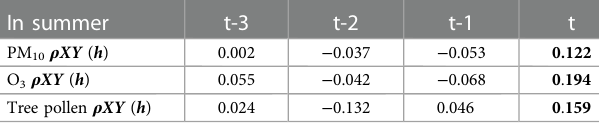
Bold values represent highest cross-correlation coef fi cients. t-n: n weeks ago. ρ XY ( h ): cross-correlation coef fi cient.